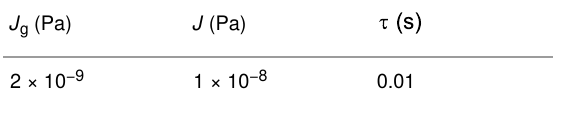
Table 1: Material parameters used in the simulations. J g (Pa)